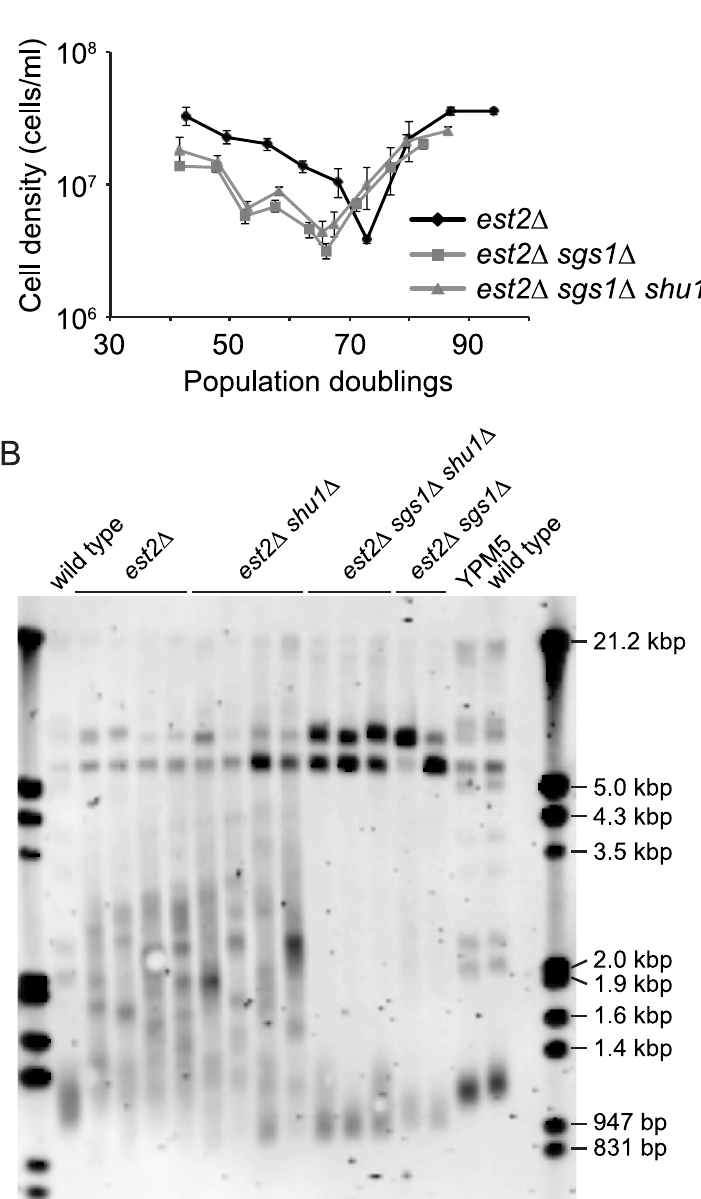
Fig 3. Rapid senescence and type II survivor formation defect of est2 Δ sgs1 Δ cells are not rescued by deletion of SHU1 . ( A ) Strains for the indicated genotypes, generated from the sporulation of an est2 Δ